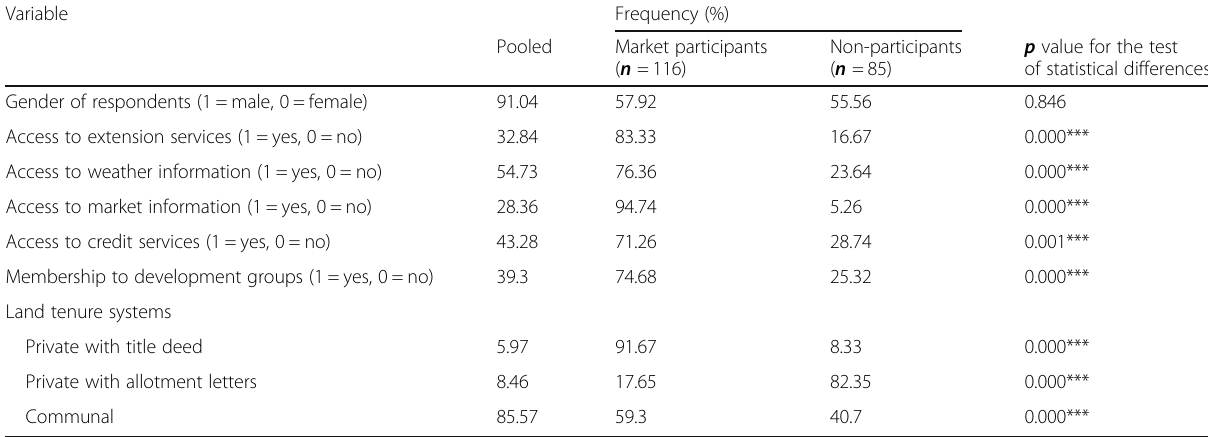
Table 2 Institutional